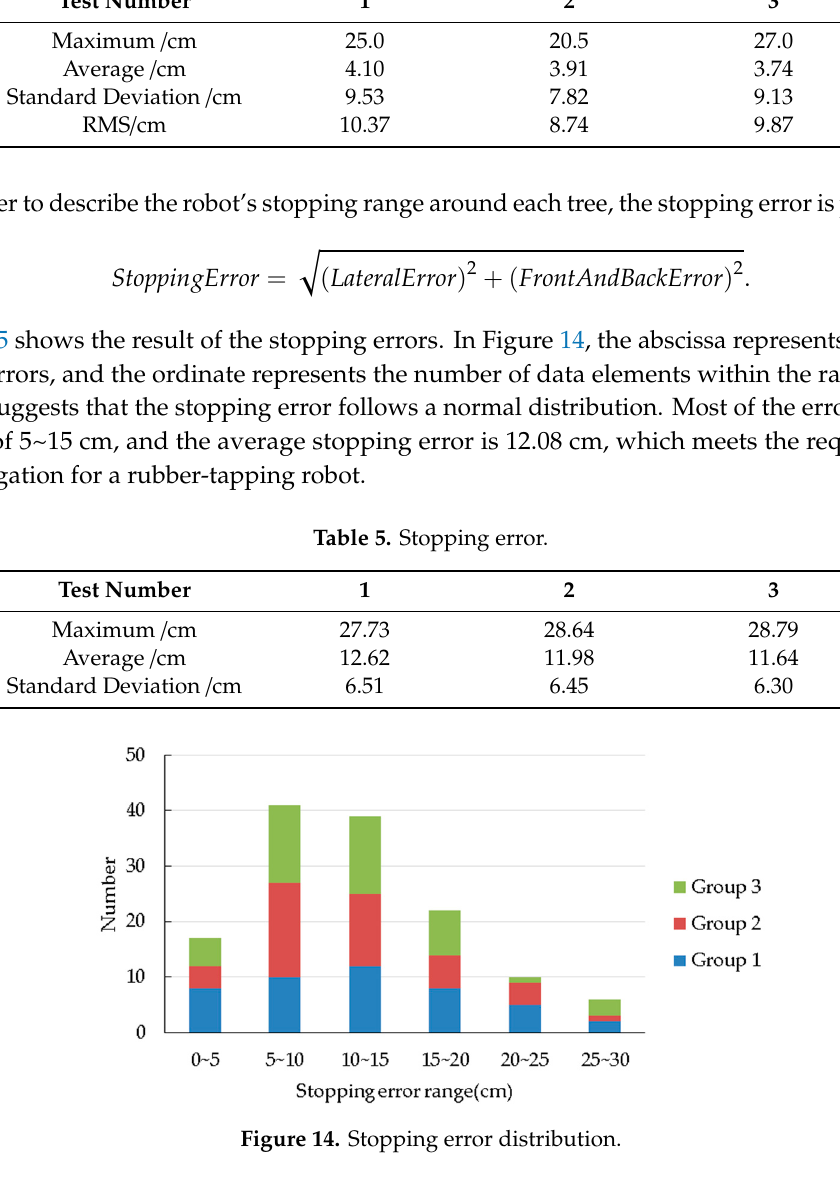
Figure 13. The change in lateral error in the second test.